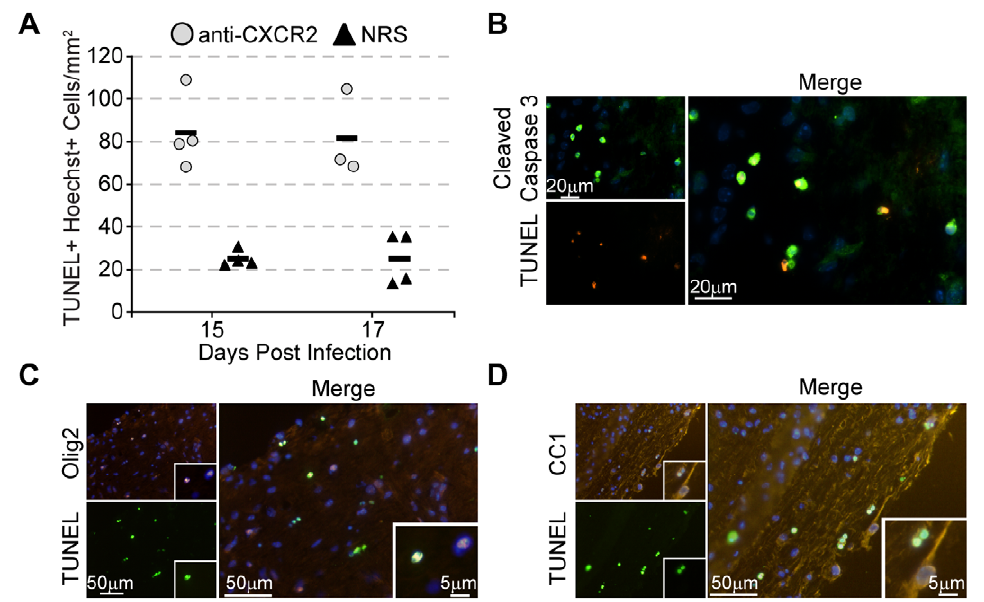
Figure 6. CXCR2 neutralization increases oligodendrocyte lineage cell apoptosis in the spinal cord. C57BL/6 mice were i.c. infected with 500 PFU JMHV and were treated with CXCR2 neutralizing antiserum or control normal rabbit serum (NRS) every other day beginning at day 12 p.i. Mice were sacrificed at day 15 and 17 p.i. and spinal cords were removed and processed for TUNEL labeling. ( A ) Quantification of the number of white matter TUNEL-positive nuclei revealed an approximate 3 to 4 fold increase in the number of apoptotic cells in anti-CXCR2 treated mice (*** p , 0.001) compared to NRS-treated mice atdays 15 and17 p.i. ( B ) Co-immuno fluorescenceof TUNEL withcleaved caspase 3 confirmedthat TUNEL reactivecellswere indeed apoptotic. Immunophenotyping the TUNEL-positive cells revealed apoptotic ( C ) CC1 + oligodendrocytes and ( D ) Olig2 + oligodendrocyte precursor cells. Data presented is representative of two independent experiments. Bars: ( B ) 20 m m; ( C & D ) 50 m m; ( C & D ) inset 5 m m.